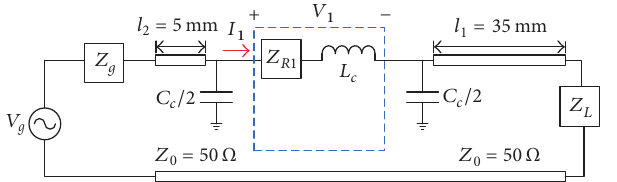
Figure 8: Simplified equivalent circuit of a band suppressed cone type monopole UWB antenna.